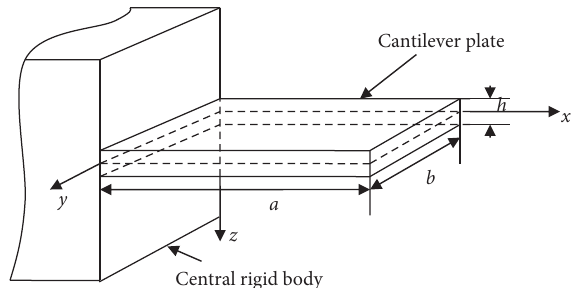
Figure 1: Model of the cantilever